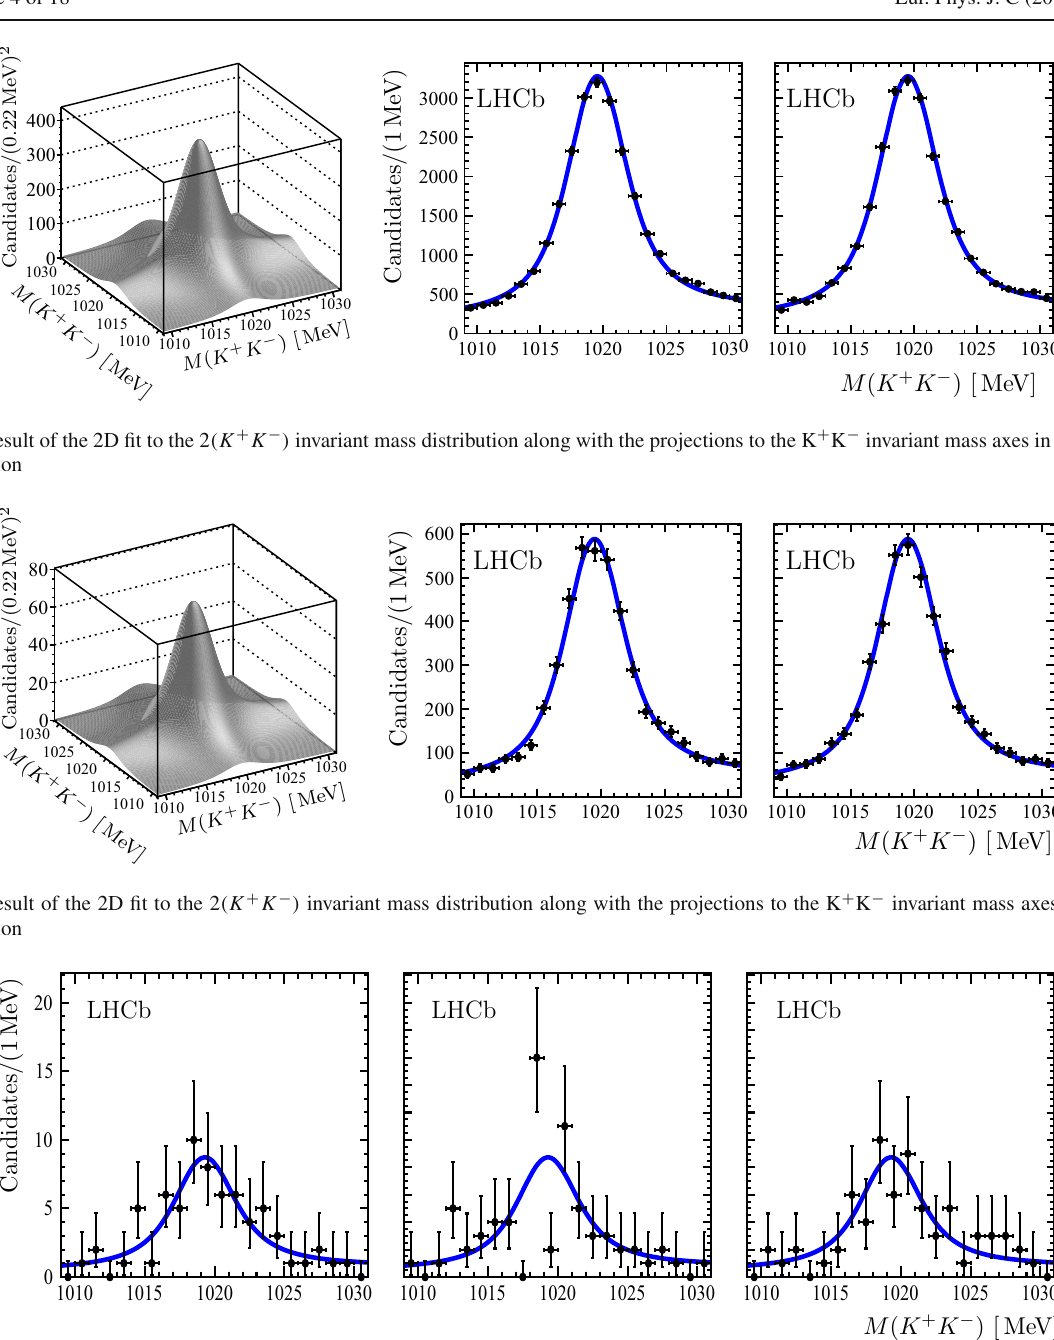
Fig. 3 Projections to the K + K − invariant mass axes of the 3D fit to the 3 ( K + K − ) invariant mass distribution in the B 0 s signal